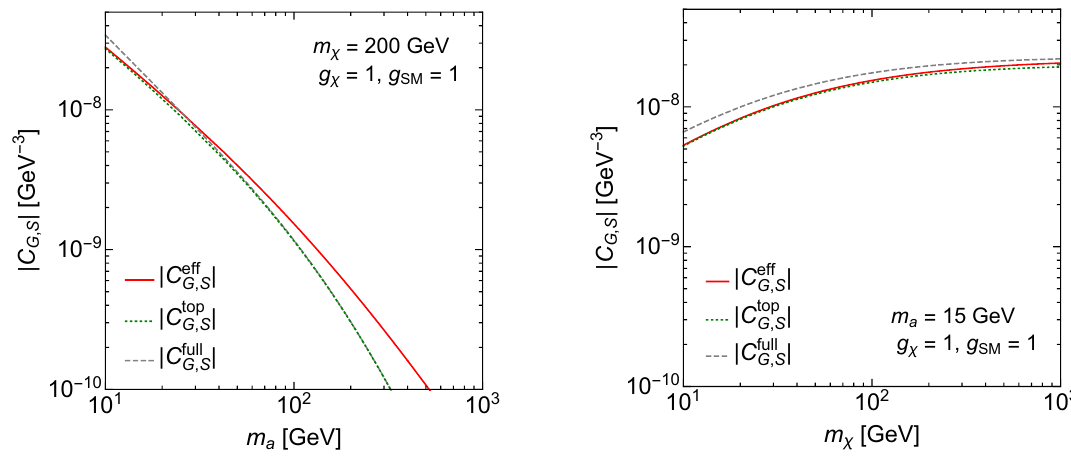
Figure 4 . Comparison of in the e(cid:11)ective approach for the top quark (red), the two-loop jC G;S j contribution of the top quark (dotted green) and the two-loop result including all heavy quarks (dashed grey) as a function of m a (left panel) and m (cid:31) (right panel). For both plots we set (cid:30) (cid:31) = 0 and (cid:30) SM = (cid:25)=